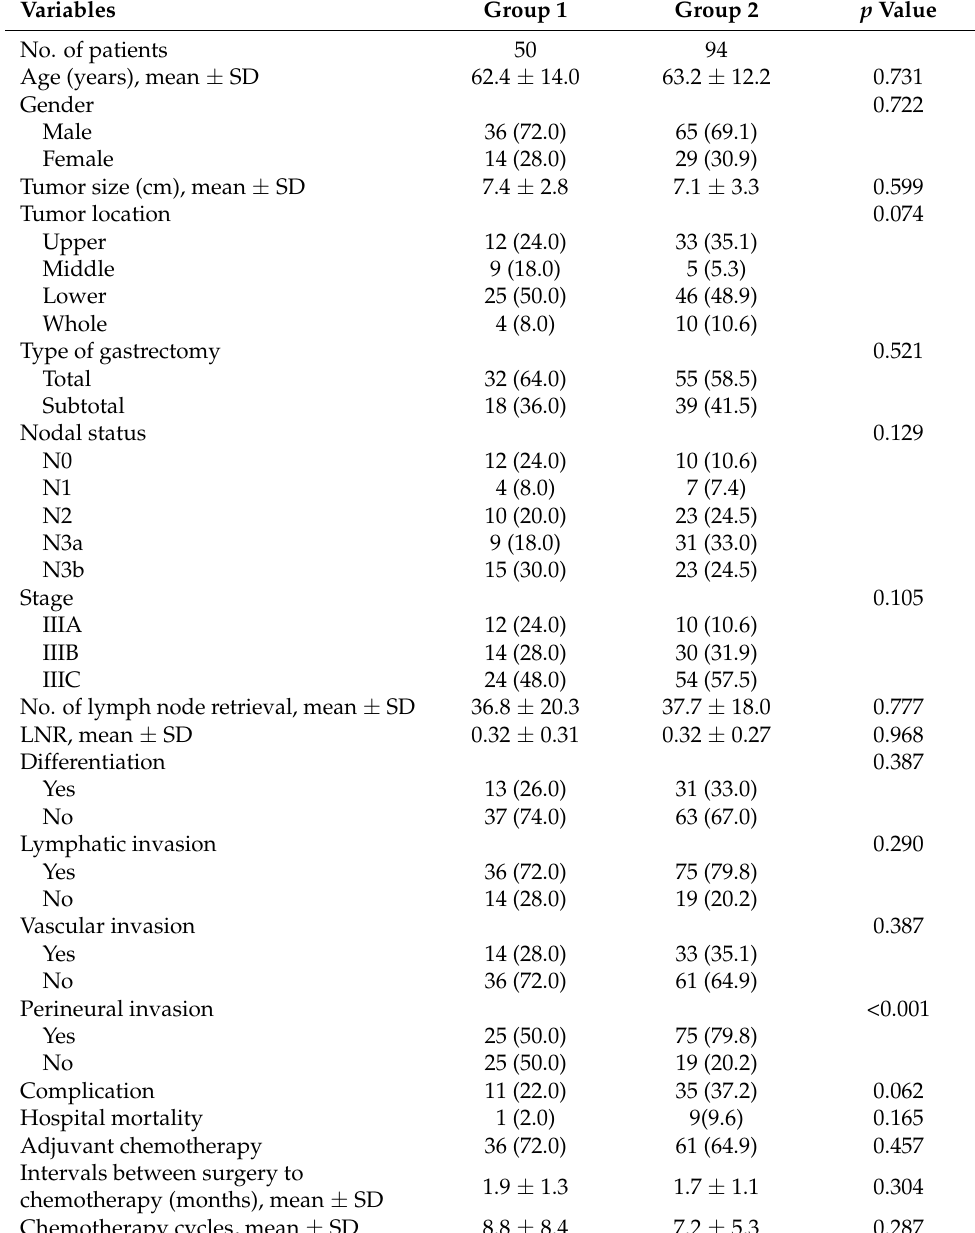
Table 1. Demographics and clinicopathological features between group 1 and 2